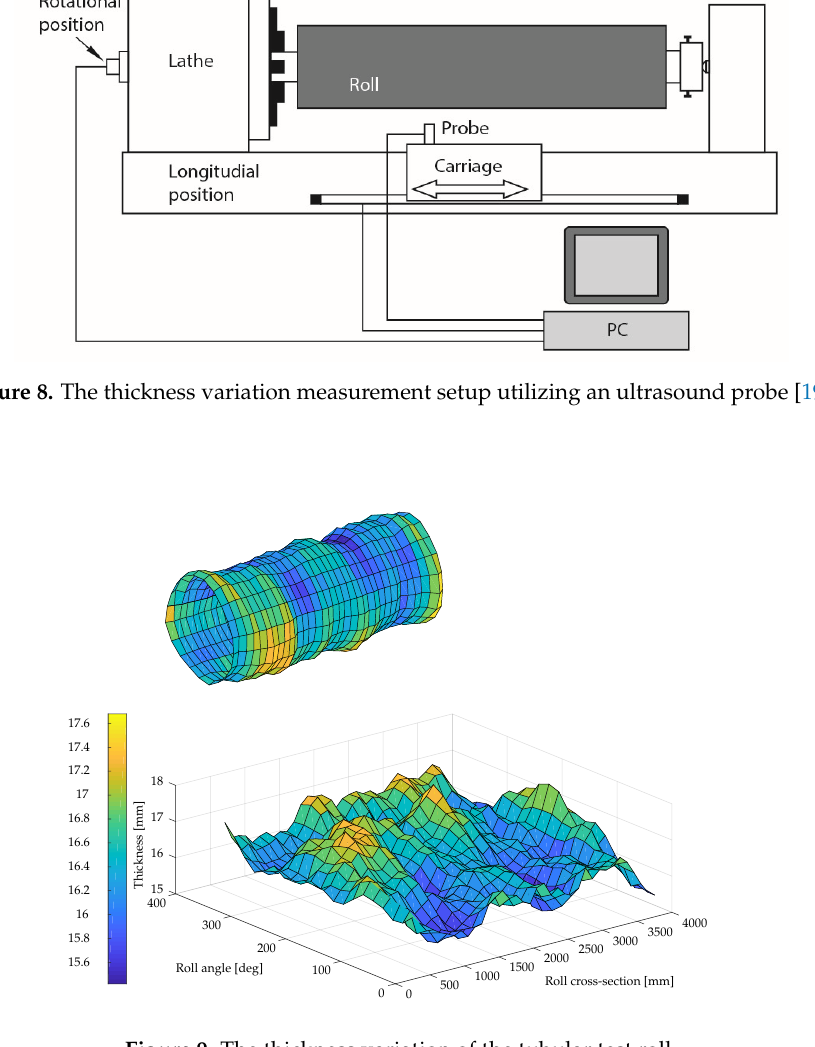
Figure 9. The thickness variation of the tubular test